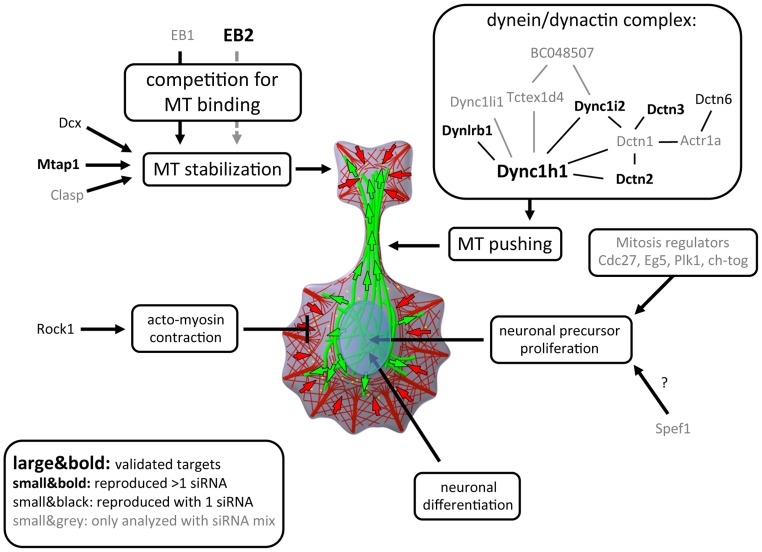
Proposed roles for cytoskeletal regulators in neurite formation.A model for the role of microtubules in neurite formation is presented. Several genes identified in this screen influence distinct functional layers of this process. The grey, dashed arrow pointing from EB2 indicates weak microtubule stabilizing activity compared to EB1. (Large&bold: gene targets, which were validated for multiple independent siRNAs via western blot analysis; small&bold: gene targets, which were reproduced with at least two independent siRNAs in secondary screens; small&black: gene targets, which were reproduced with one single siRNAs in secondary screens; small&grey: candidates, which were analyzed only with siRNA mixtures).